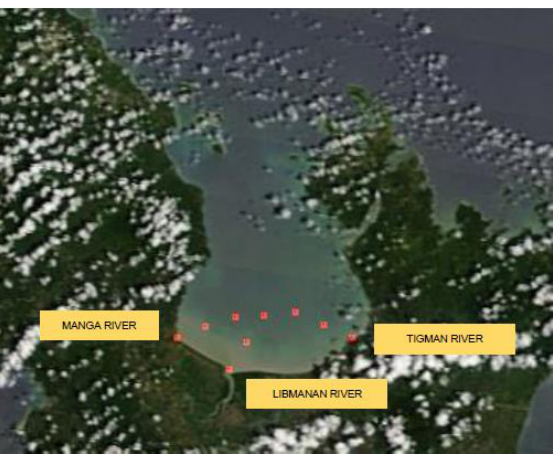
Figure 8. River Mouth and decay points of the three rivers in